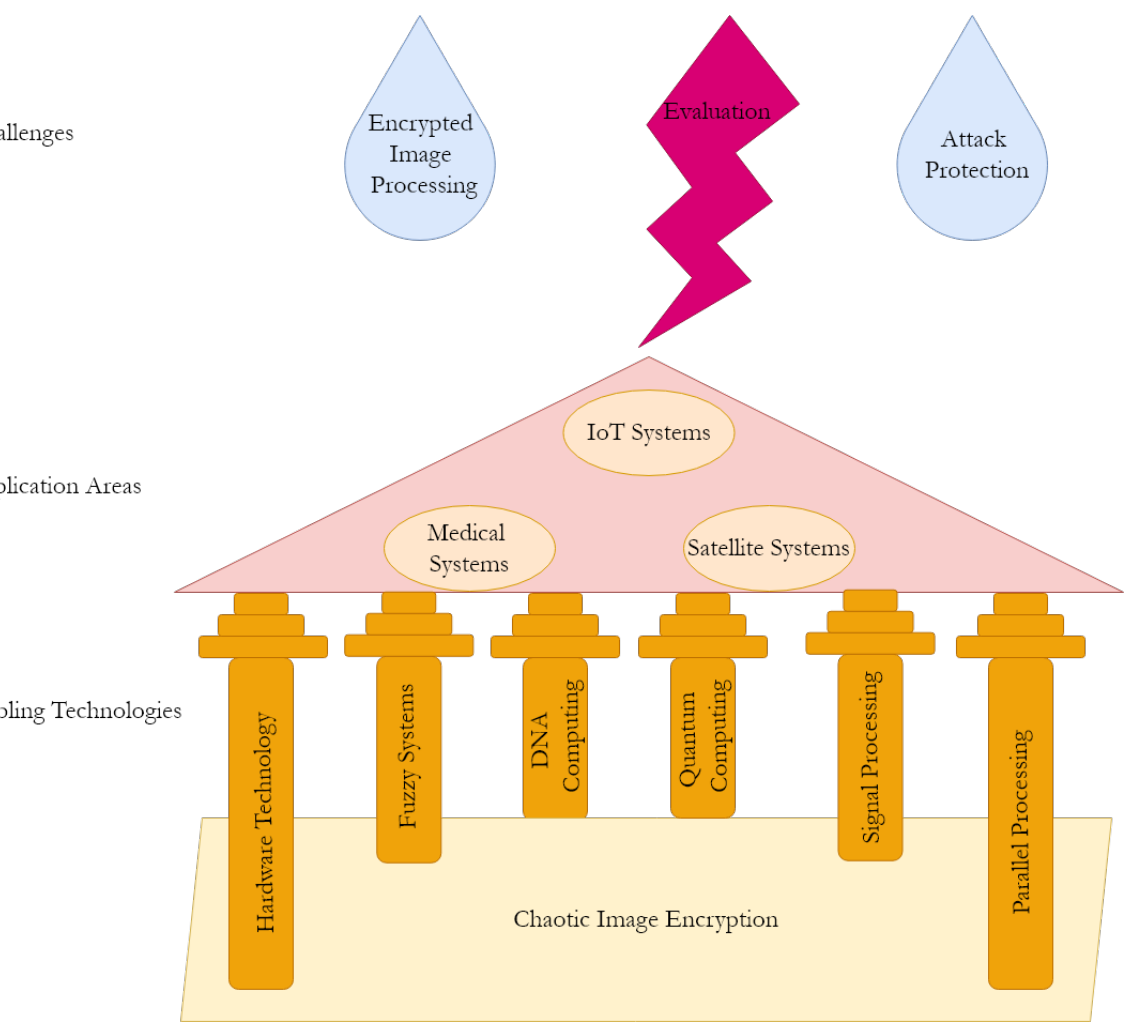
Figure 3. The Ecosystem of Chaotic Image